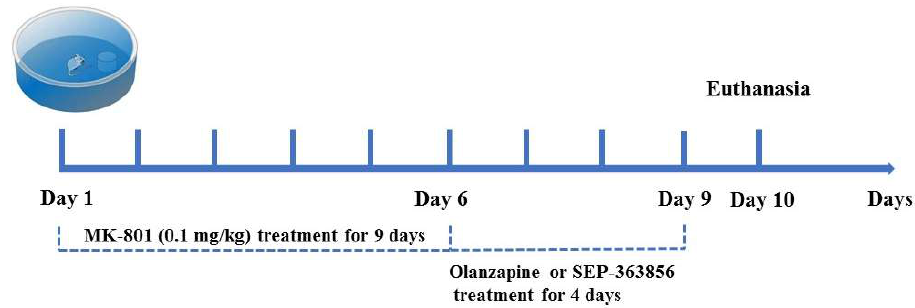
Figure 5. Schematic diagram of experiment schedule. MK-801 (0.1 mg/kg) was administered 20 min before behavioral testing for a total of 9 days. Following 6 days of treatment with MK-801, olanzapine and SEP-363856 were administered 40 min and 10 min before MK-801 administration, respectively, for a total of 4 days. Spatial memory performance was measured in a Morris water maze test over 9 days (4 trials/day).